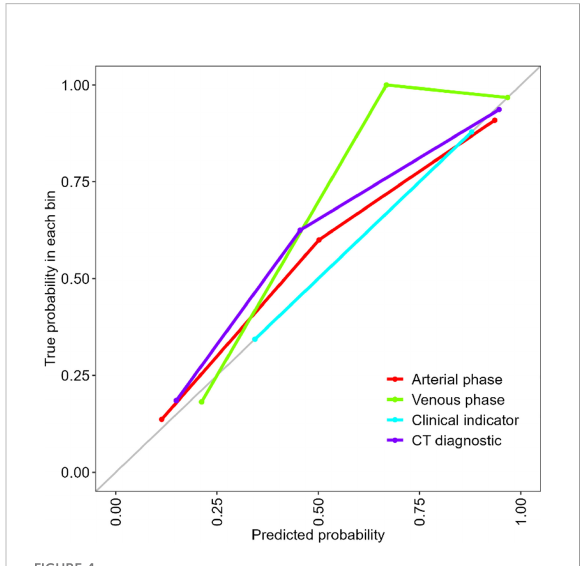
FIGURE 4 Calibration curve for the arterial phase model, venous phase model, clinical indicators model and the traditional CT diagnostic criteria. The calibration of the four models was depicted by the calibration curve in terms of the agrement between the predicted risks of gastrointestinal stromal tumors (GISTs) and the actual results based on the modi fi ed criteria. The grey line represents an ideal prediction, and the other lines represent the predictive performance of the models. The closer the fi t of the purpole line to the ideal line, the better the